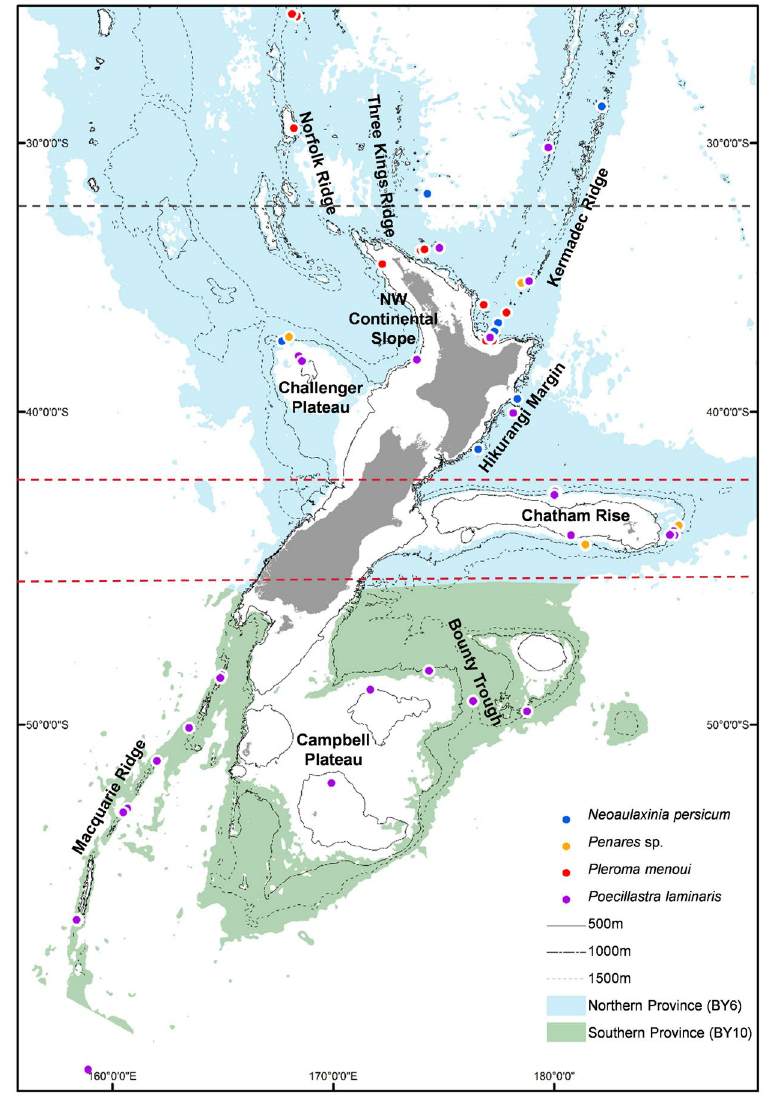
Figure 4. Map showing the locations of samples for the study species. Hierarchical testing of regional genetic differentiation is employed: (1) blue (northern) and green (southern) backgrounds represent the two biogeographic lower bathyal provinces (BY6 and BY10) of Watling et al . 54 in the New Zealand region; (2) red dashed lines at 42°S and 45°S indicate boundaries between north ( < 42°S), central (42°S to 45°S) and south ( > 45°S) regions for Poecillastra laminaris and Penares sp. and black dashed line at 32°S shows boundary between north and south regions for Neoaulaxinia persicum and Pleroma menoui ; (3) major geomorphic features as named on the